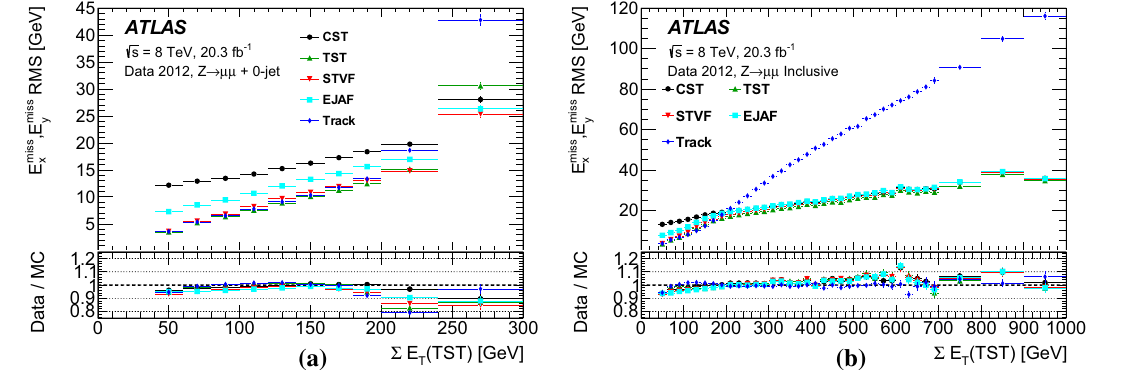
Fig. 9 The resolution of the combined distribution of E miss x and E miss y for the CST, STVF, EJAF, TST, and Track E miss of (cid:5) E T (TST) in Z → μμ events in data for the a 0-jet and b inclusive